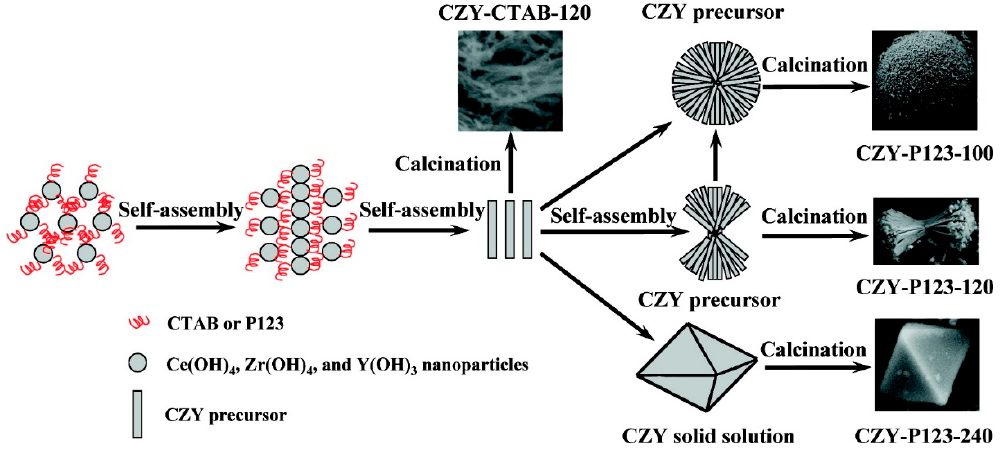
Figure 20. A schematic illustration of formation mechanisms of the ceria-zirconia-yttria precursors and ceria-zirconia-yttria solid solutions under surfactant-assisted (CTAB or P123) hydrothermal and calcination conditions [173]. Reprinted with permission from Zhang, Y.; Zhang, L.; Deng, J.; Dai, H.; He, H. Controlled Synthesis, Characterization, and Morphology-Dependent Reducibility of Ceria − Zirconia − Yttria Solid Solutions with Nanorod-like, Microspherical, Microbowknot-like, and Micro-octahedral Shapes. Inorg. Chem. 2009 , 48 , 2181–2192. Copyright (2009) American Chemical Society.